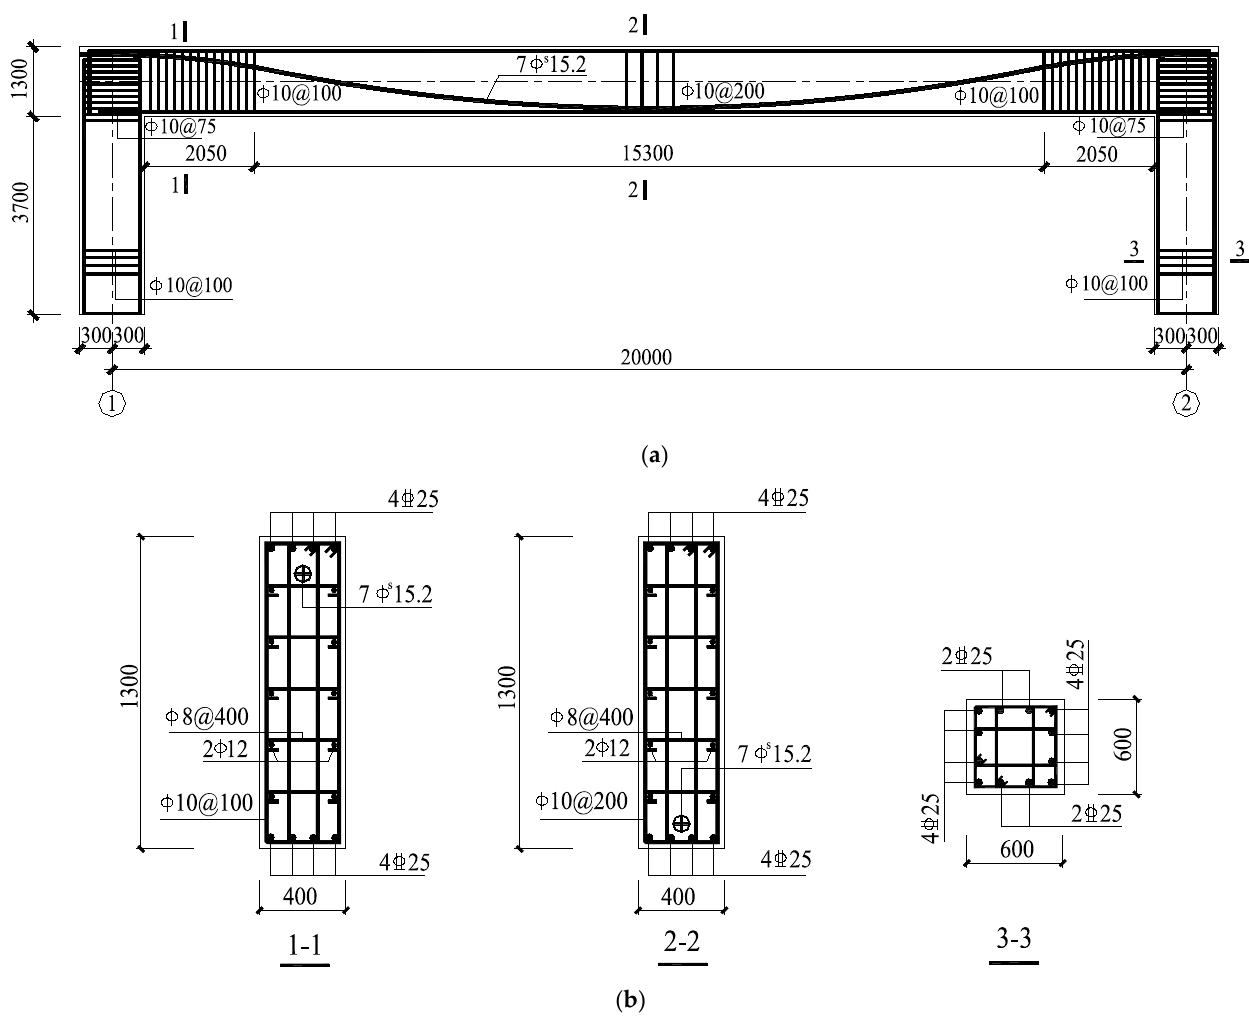
Figure 4. Elevation view and reinforcement drawings of prestressed concrete frame (Unit: mm). ( a ) Elevation of prestressed frame. ( b ) Sectional reinforcement diagram Table 1. Parameters of finite element